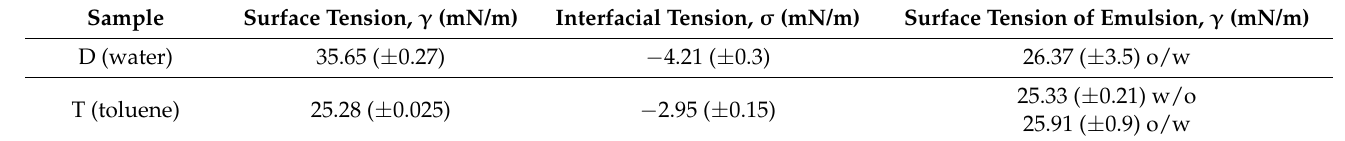
Table 2. Surface properties of 1 g/L solutions of the two amphiphilic siloxane compounds used as stabilizers.